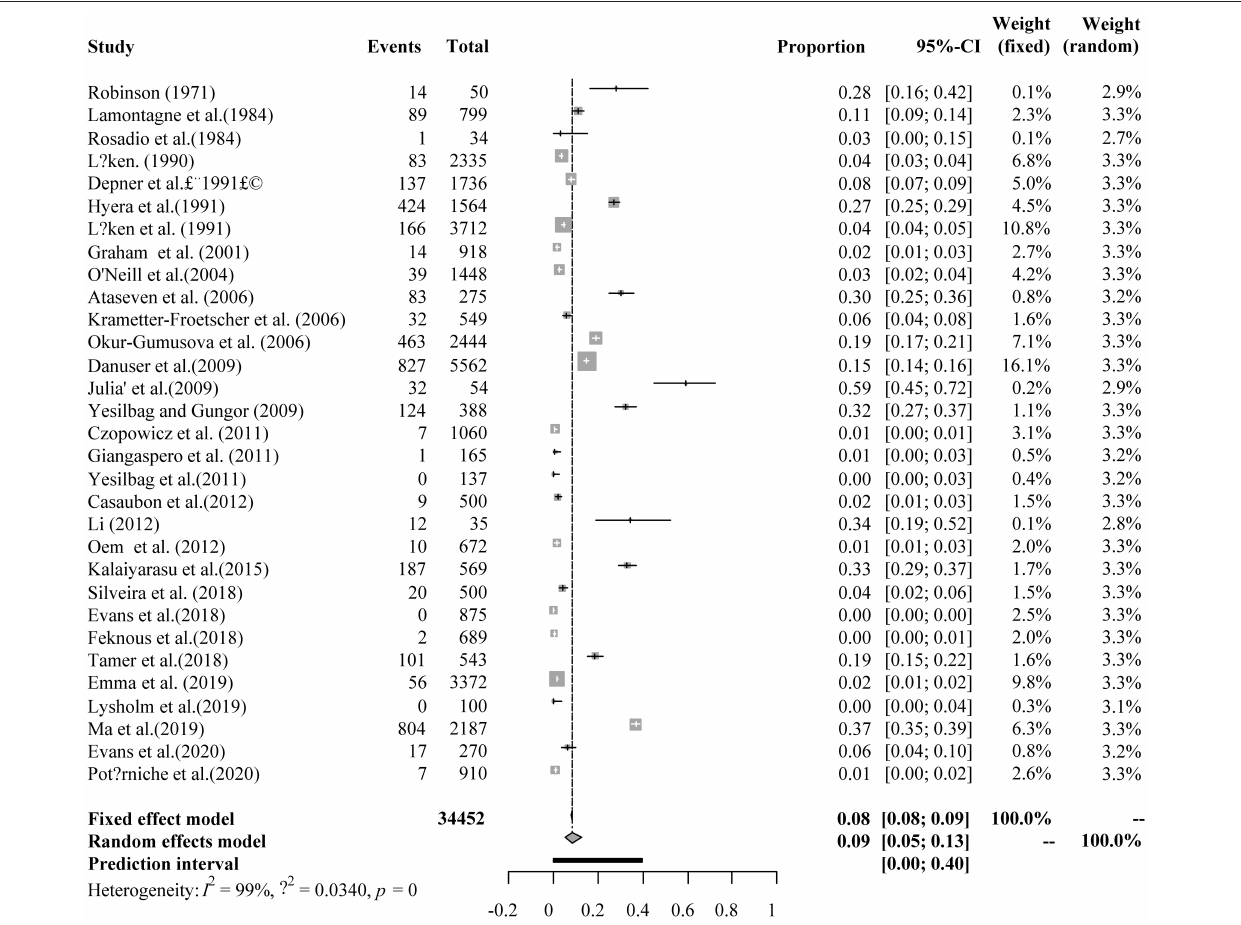
FIGURE 4 | Random-effects meta-analysis of BVDV infection in sheep and goats (Immunological methods).